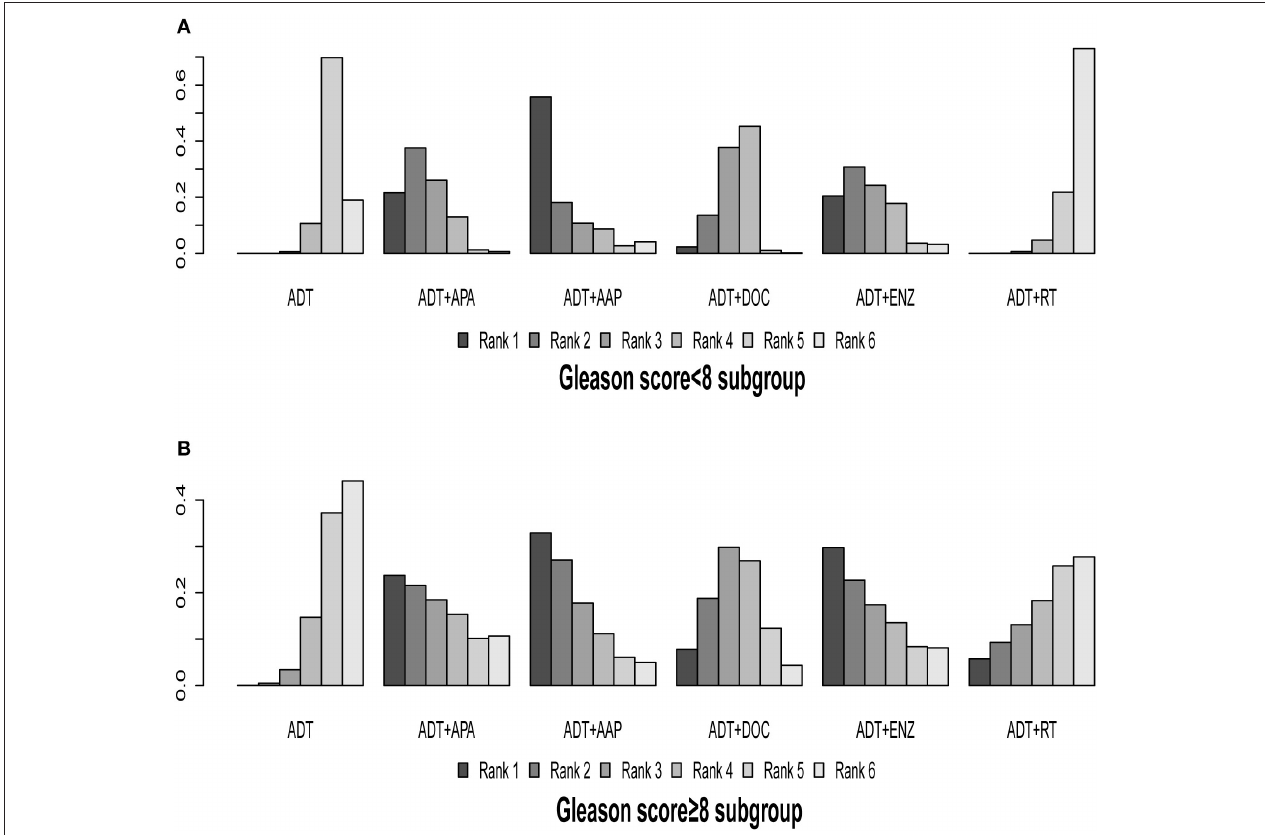
FIGURE 7 | Ranking plot based on the probabilities of interventions in patients with different Gleason scores: (A) Gleason score < 8 subgroup; (B) Gleason score ≥ 8 subgroup. The height of every column refers to the probabilities of the rank. The actual outcome being measured in this figure was overall survival.